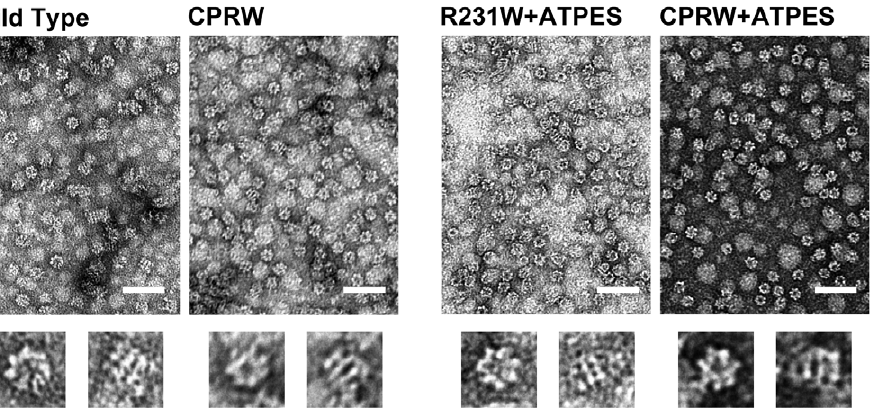
Figure 6. Electron Micrographs of GroEL CP376-RW. Samples were stained with 1% uranyl acetate. The scale bar in each figure indicates 100 nm. Magnification was x 60,000. Wild Type denotes wild type GroEL, R231W indicates GroEL R231W. CPRW denotes samples of GroEL CP376-RW, and + ATPES indicates samples where 0.2 mM ATP and an equimolar concentration of GroES were added in the course of sample preparation (see Materials and Methods). Below each panel, representative zoomed images of an end-on view (left) and side view (right) particle for each sample are shown.